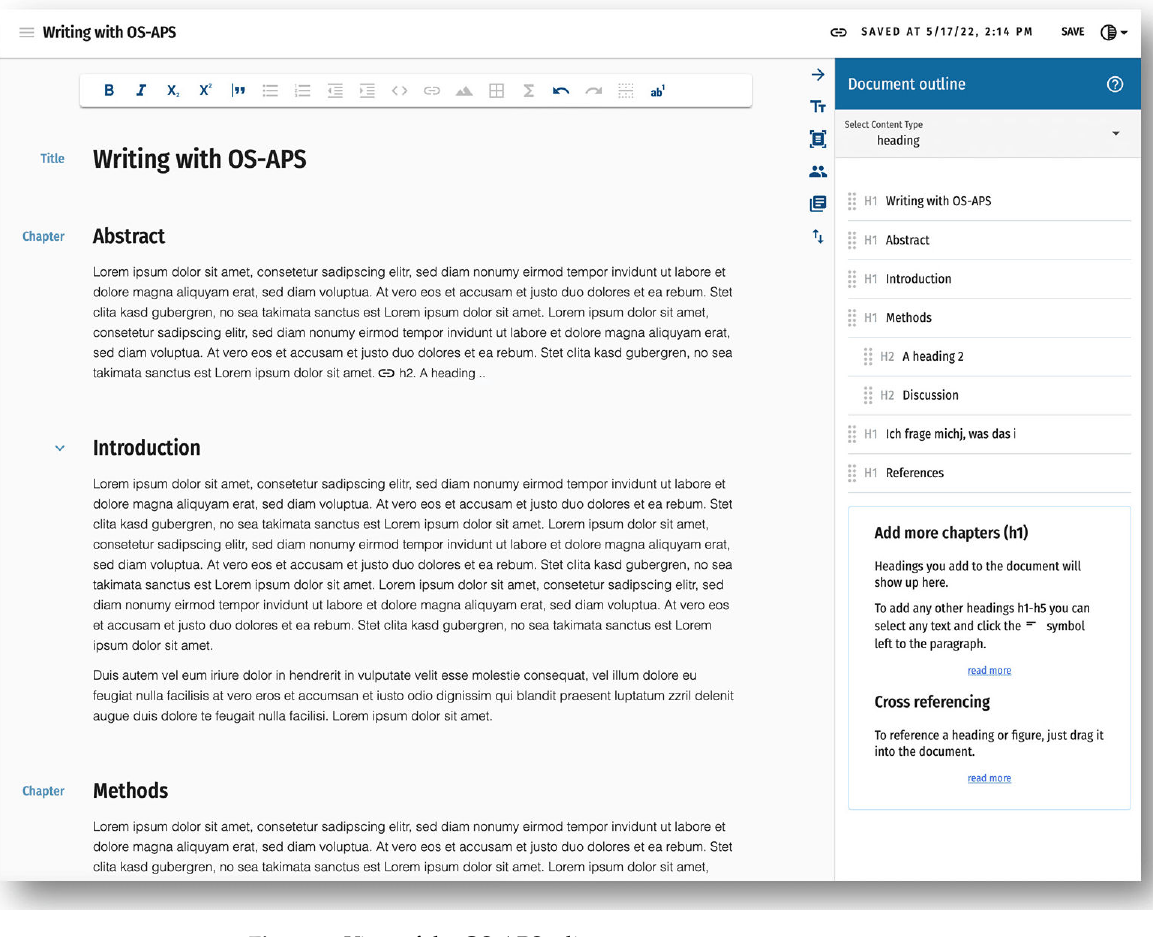
Figure 3. View of the OS-APS